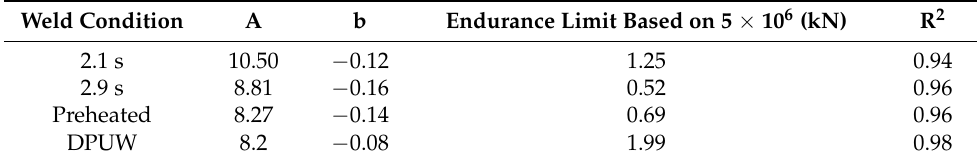
Table 1. Fatigue S–N curve data for ultrasonically welded CF/PA66 composite. Weld